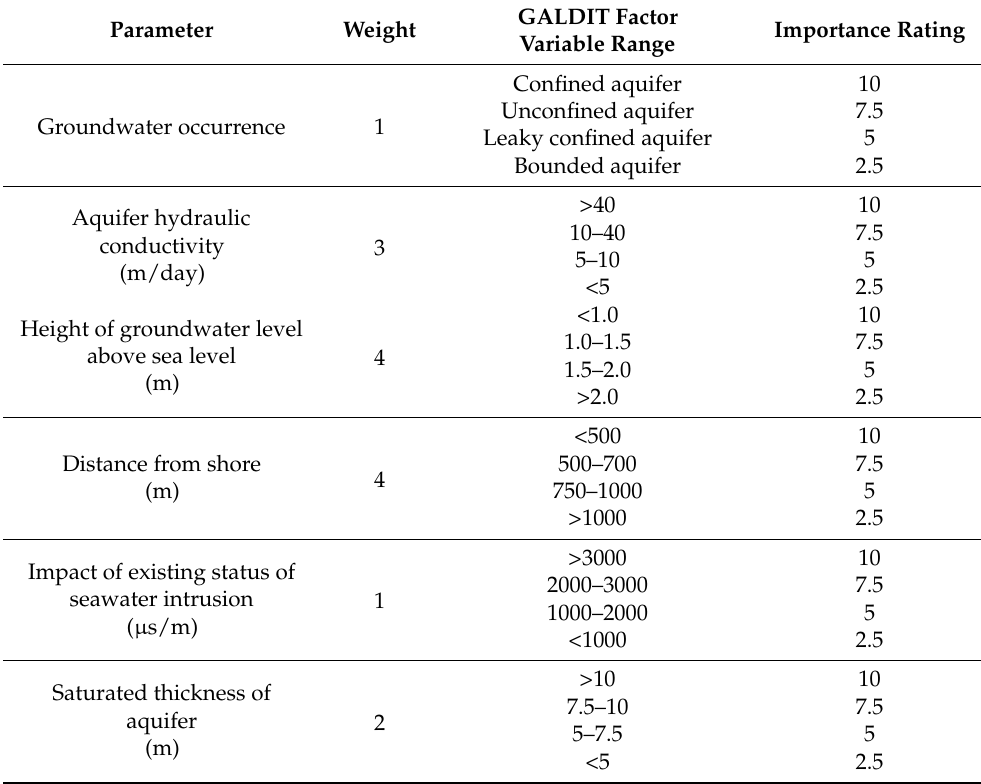
Table 1 lists the ratings and weights according to the criteria for each parameter. According to the scoring method of the existing GALDIT, the highest score was 10, whereas the lowest was 2.5. The highest score was divided using the quartile method into 10, 7.5, 5, and 2.5, according to the parameter range. In this study, the GALDIT factor variable range and the importance rating in the two columns were modified in the right column of Table 1. Thus, the highest score of 10 was divided by using the decile method, and a score between 1 and 10 was assigned for the modified importance rating. The existing quartile method was used to classify aquifers according to their hydrogeological characteristics. The new distributions of scores for other parameters are listed in Table 2. Table 1. Theoretical weights and rates for GALDIT.